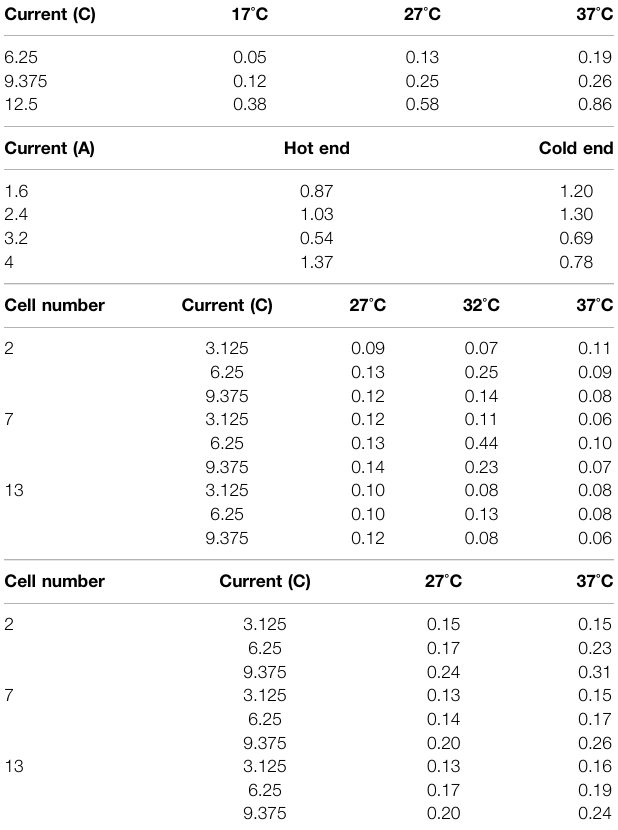
TABLE 2 | AE ave values of different thermal models ( ° C). (Panel A) Cell thermal model(Panel B)Semiconductor thermalmodel(Panel C)Batterypack thermal model(Panel D) BTMS thermal